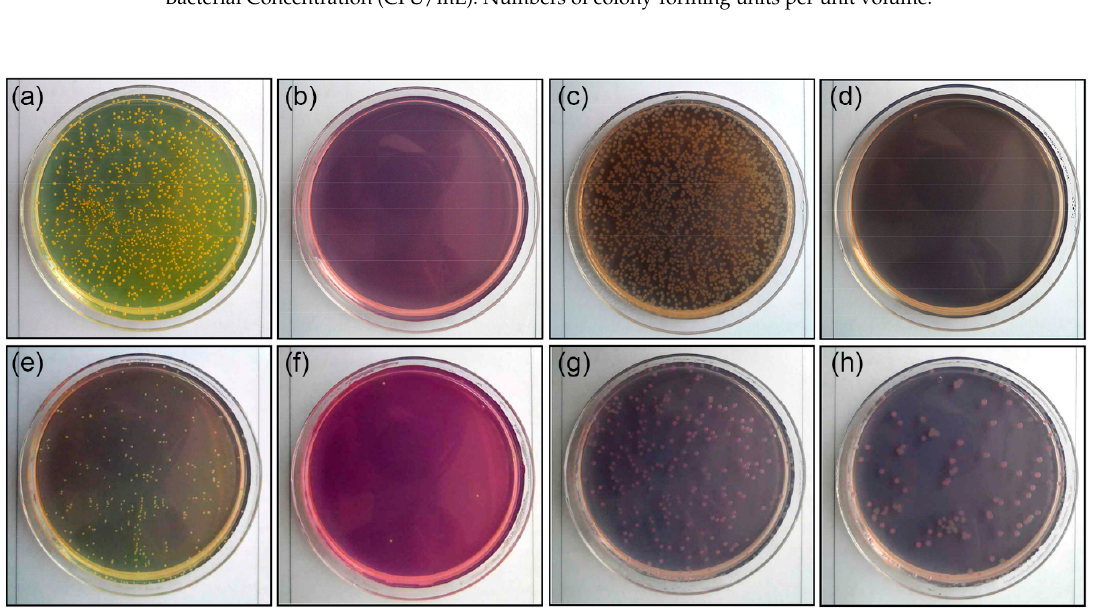
Figure 5. Antibacterial activity analysis of S. aureus for ( a ) blank and ( b ) nanocomposite films of PAN and CPNs at 0.75 wt %, and E. coli for ( c ) blank and ( d ) nanocomposite films of PAN and CPNs at 0.75 wt %. That of S. aureus ( e ) before and ( f ) after washing, and K. pneumoniae ( g ) before and ( h ) after washing fabrics based on PAN/CPN nanocomposite fibers.